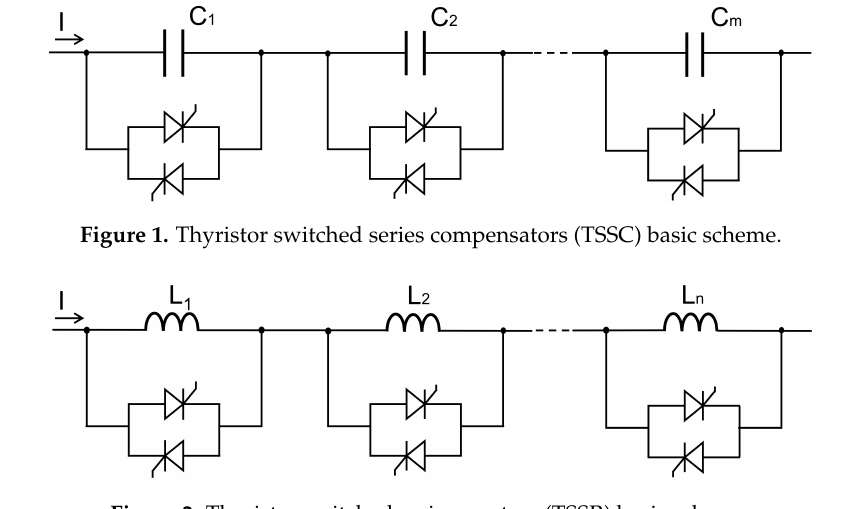
Figure 2. Thyristor switched series reactors (TSSR) basic